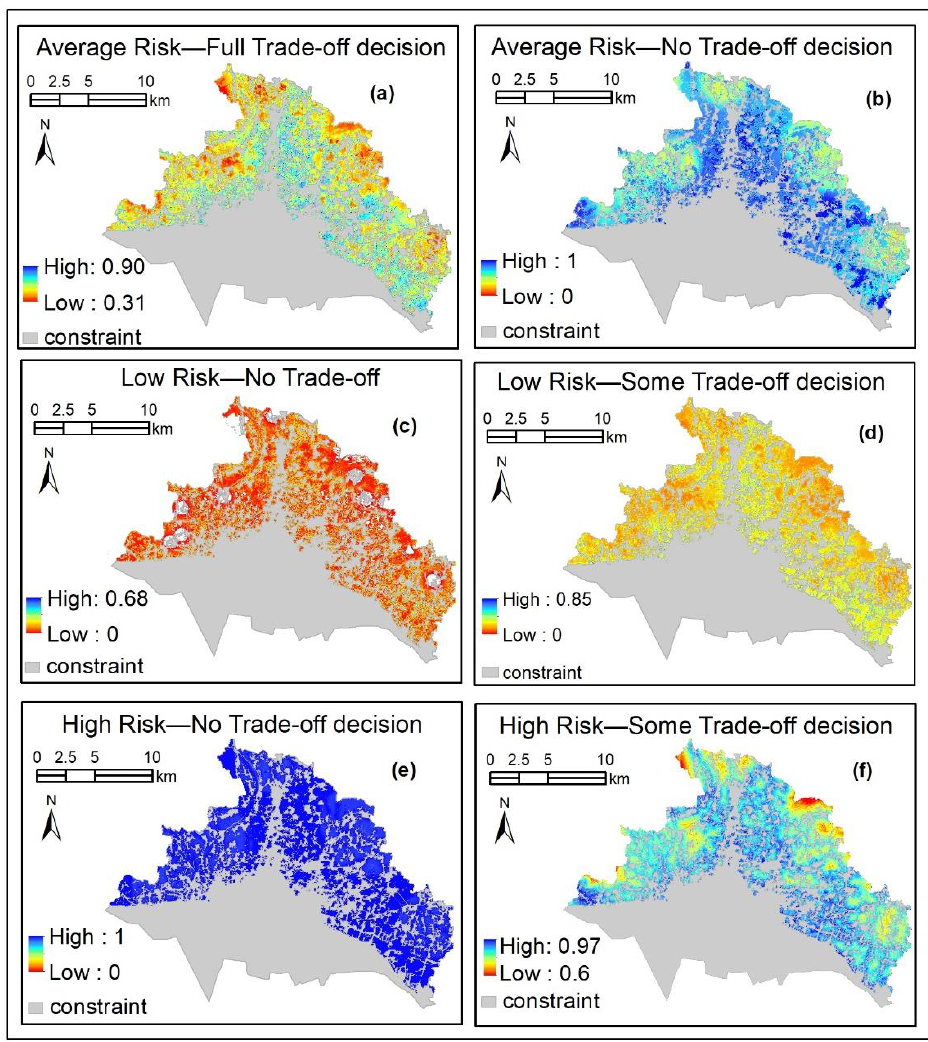
Figure 6. Weighted suitability of residential land under different decision strategies: a) average risk — full trade-off; b) average risk — no trade-off; c) low risk — no trade-off; d) low risk — some trade-off; e) high risk — no trade-off; f) high risk — some trade-off.